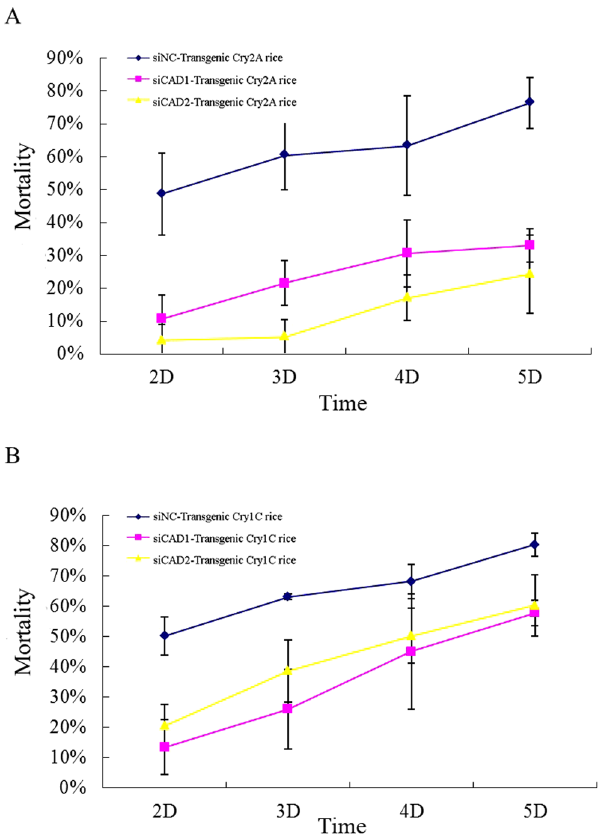
Figure 5. Mortality of Chilo suppressalis larvae treated with siRNA designed to silence the cadherin genes CsCAD1 or CsCAD2 , after feeding on transgenic rice expressing ( A ) Cry2A or ( B ) Cry1C ; siNC = negative control, si CAD1 = CsCAD1 knockdown treatment group, siCAD2 = CsCAD2 knockdown treatment